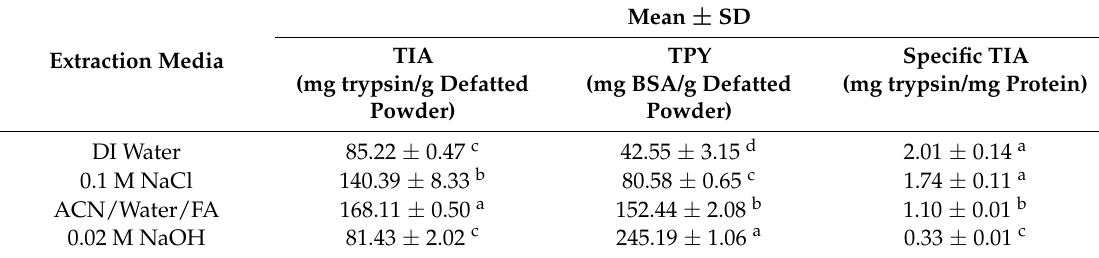
Table 3. Effect of extraction media on the extraction of Gac seed trypsin inhibitors †